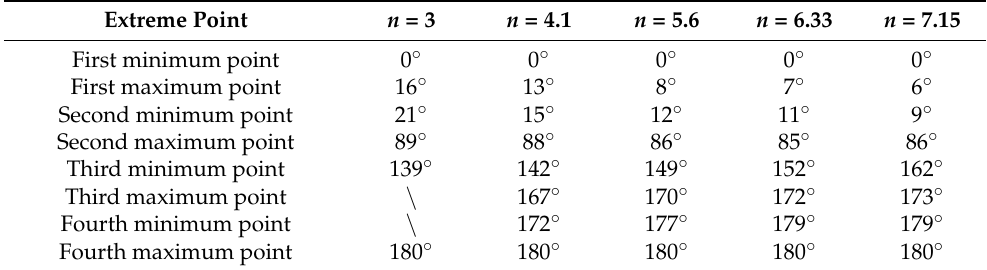
Table 1. Distribution pattern of extreme value points.